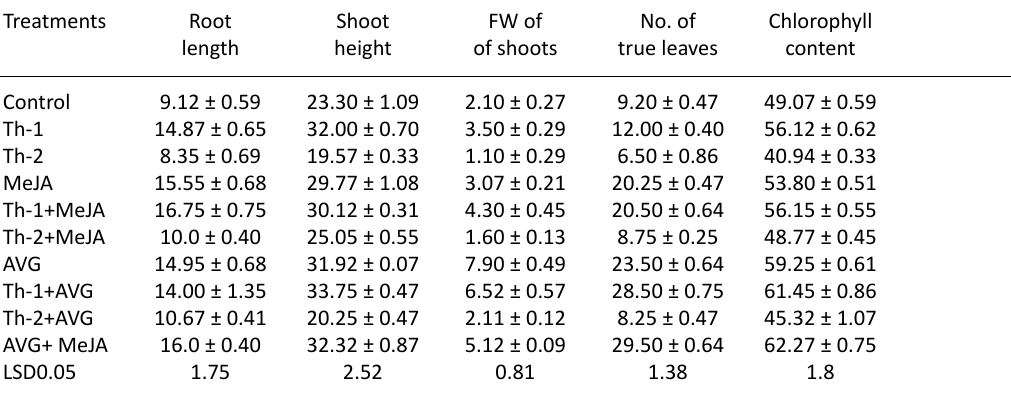
Table 2. Effects of fenugreek ( Trigonella foenum-graecum ) seed treatment with Trichoderma harzianum isolates (Th-1 and Th-2) in combination with methyl jasmonate (MeJA) and/or Aloe vera gel (AVG) on root length, shoot height, shoot fresh weight, number of true leaves, and chlorophyll content. Data are means ± standard errors of four measurements Treatments Root Shoot FW of No. of Chlorophyll length height of shoots true leaves content